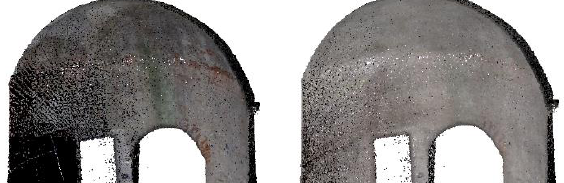
WITHOUT normal data Figure 11. Normal computation process performed in the opensource software Meshlab. The original point cloud (left) and the point cloud after the normal computation (right)